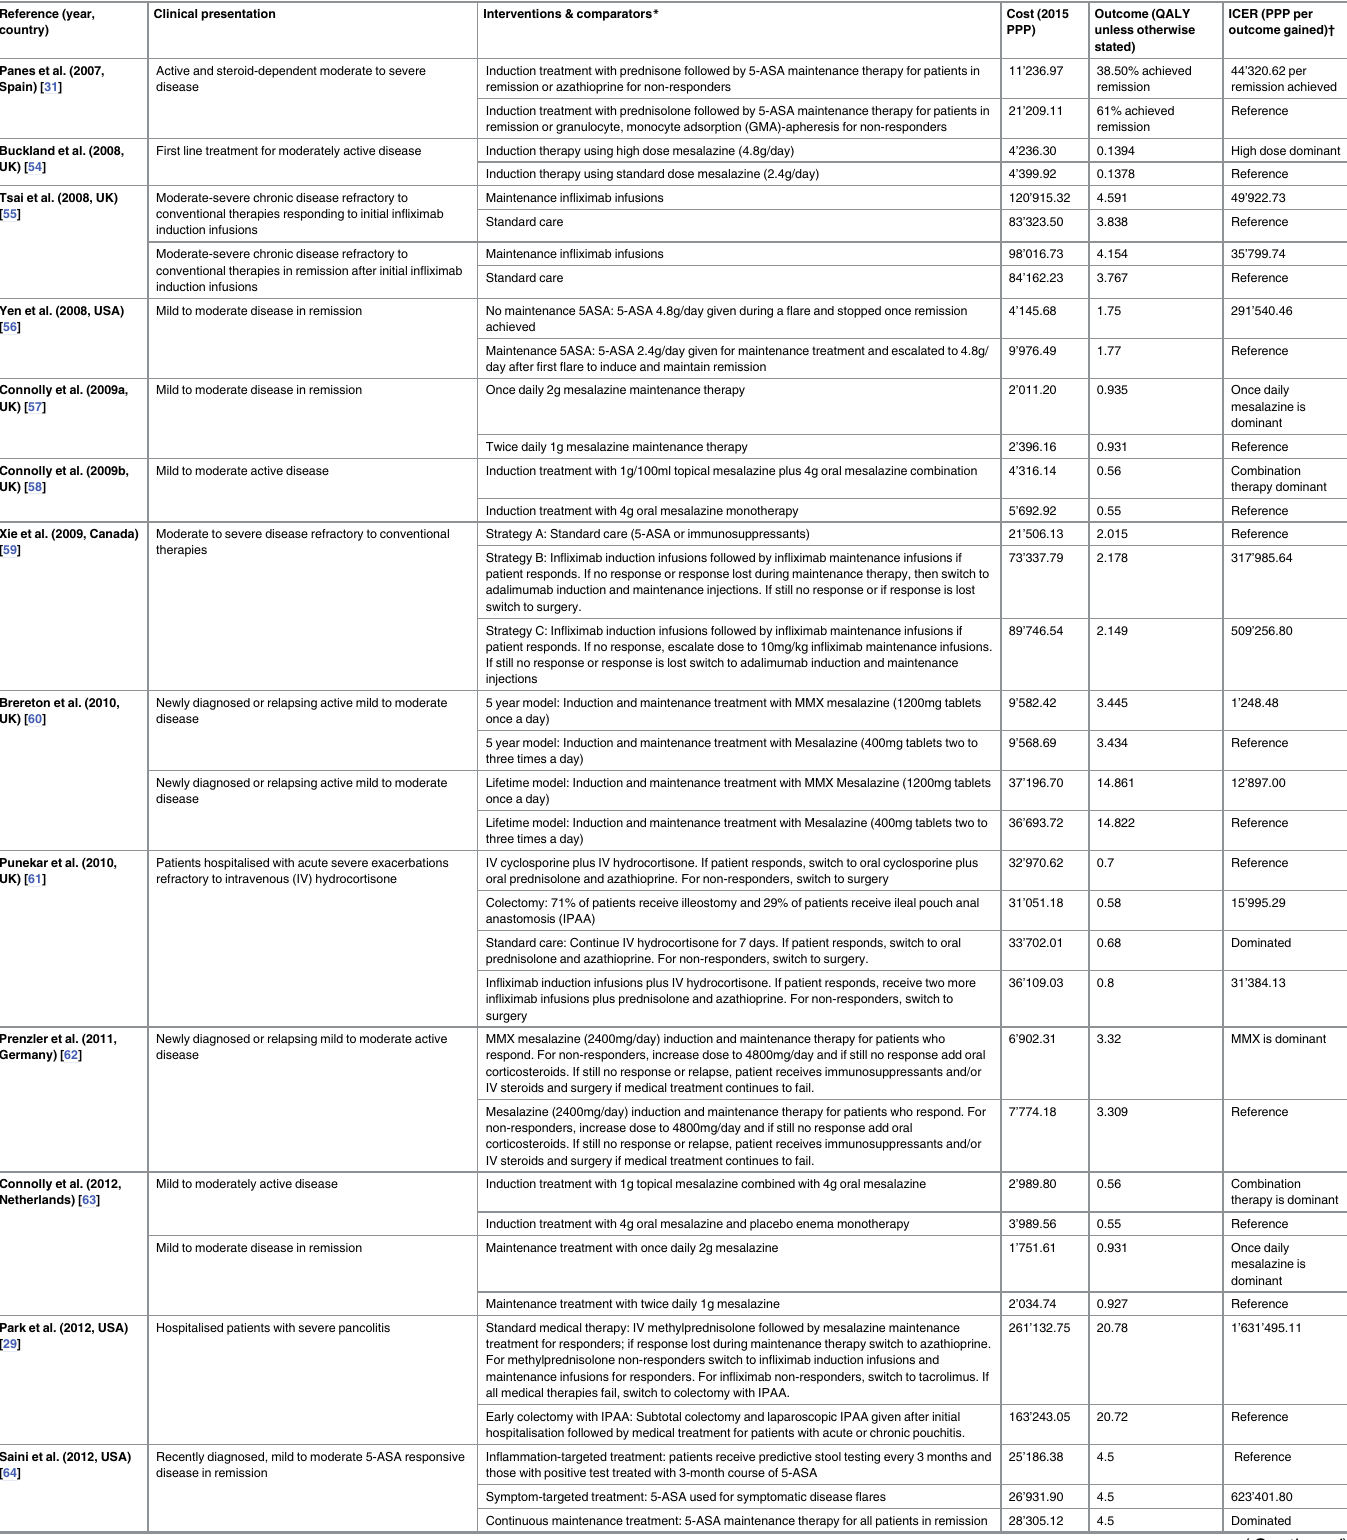
Table 3. Summaryof cost-effectivenessresults adjusted to 2015 PPP for studies on ulcerative colitis. Reference(year,